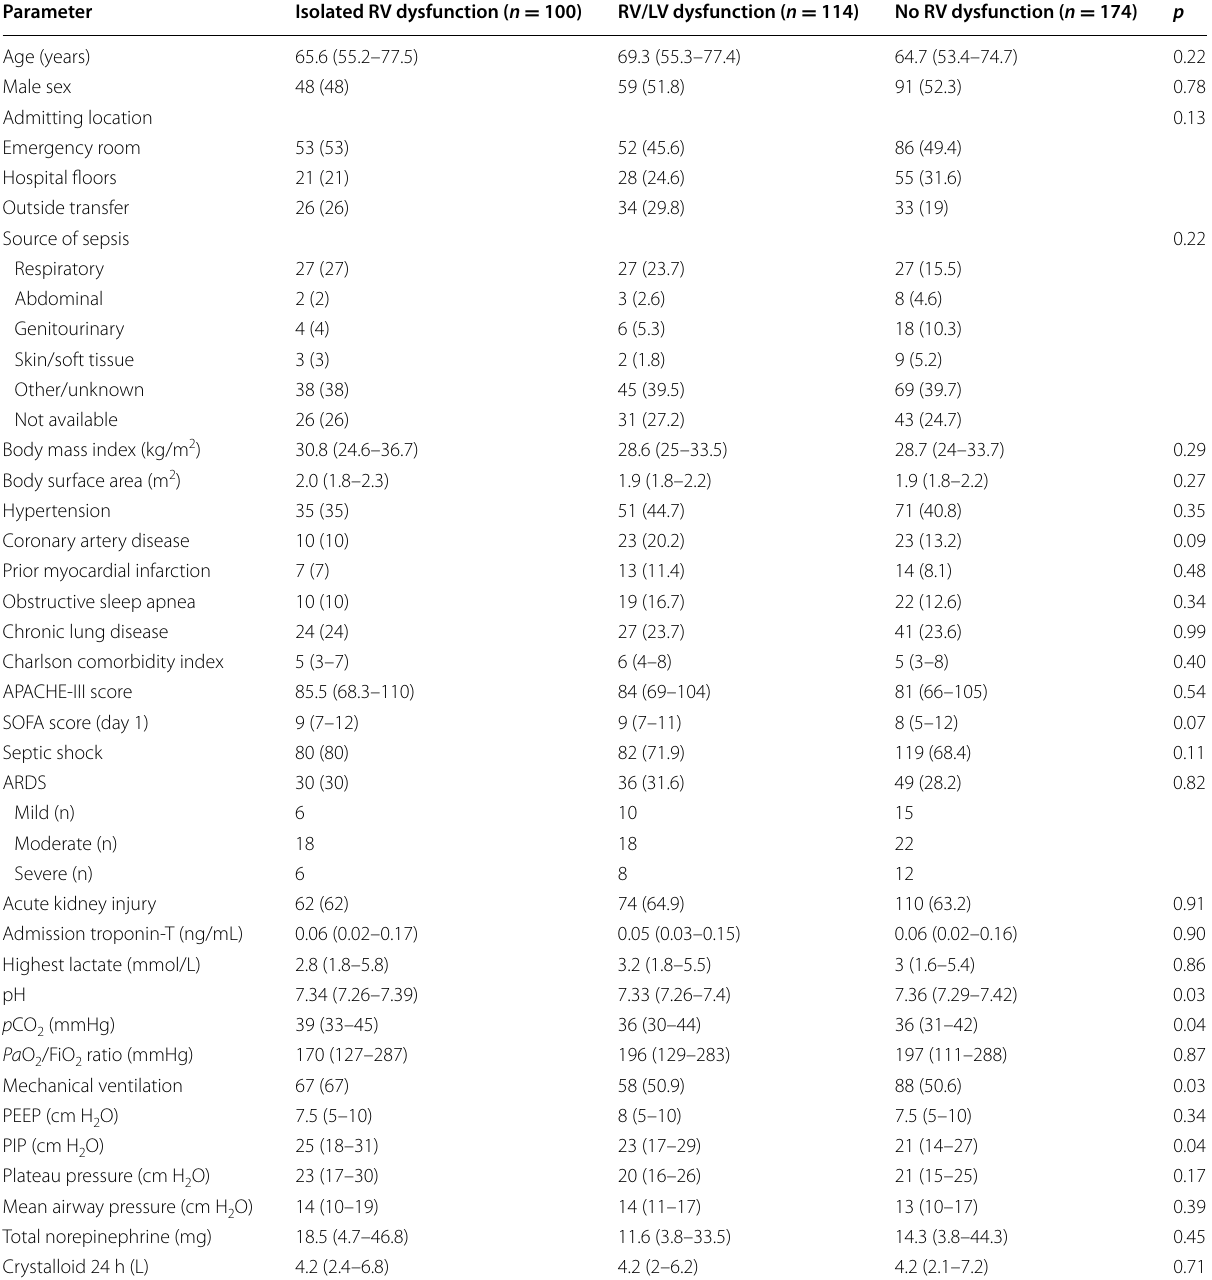
Table 1 Baseline characteristics of